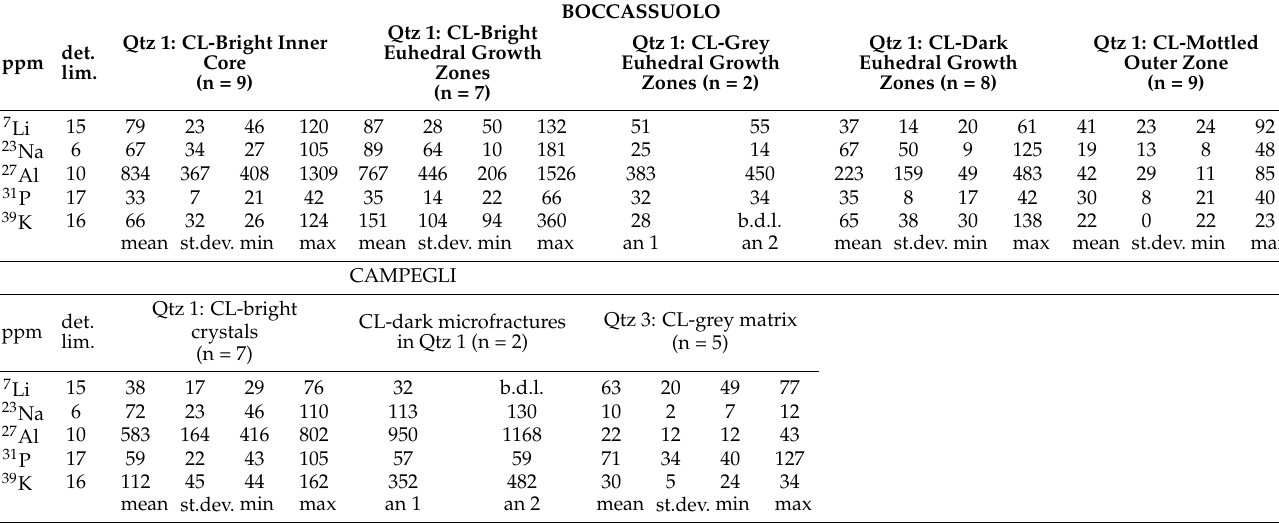
Table A1. Summary of LA-ICP-MS study